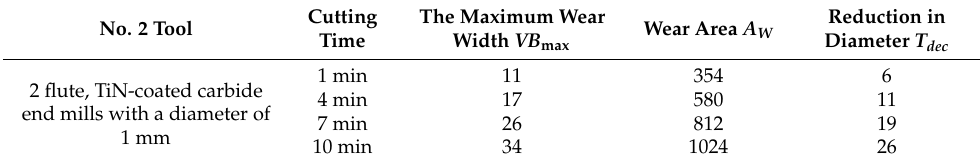
Table 4. In situ wear detection result of No.2 tool (unit: length/area of a single pixel).